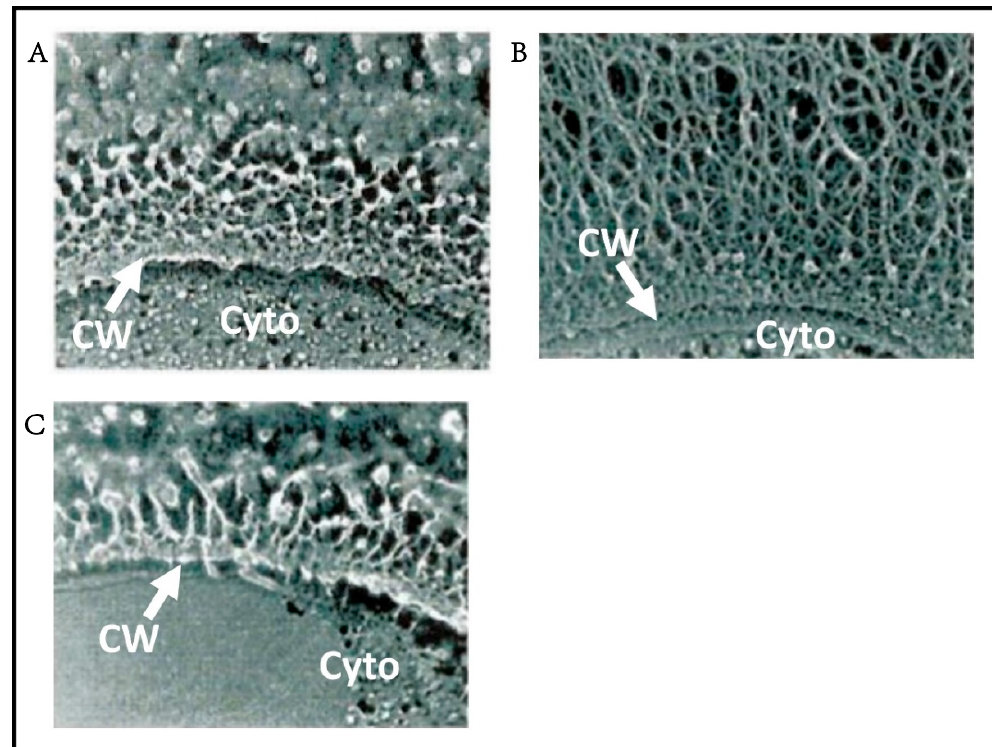
Figure 9. Hyaluronan on the surface of PBCV-1 infected C. variabilis NC64A. The figure shows cross-sections of ( A ) the surface of uninfected cells; ( B ) cells at 4 h p.i., and ( C ) cells at 4 h p.i. that were treated with hyaluronan lyase. Note: after treatment with hyaluronan lyase, the cell surface resembles the surface of uninfected cells. Chlorella cell wall varies from 50 to 100 nm in thickness [46,113]. CW is the cell wall and Cyto is the cytoplasm. Micrographs were taken from Graves et al. [204] with permission.